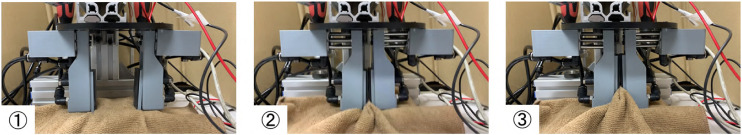
Gripping and releasing a towel with two fingered pneumatic gripper.